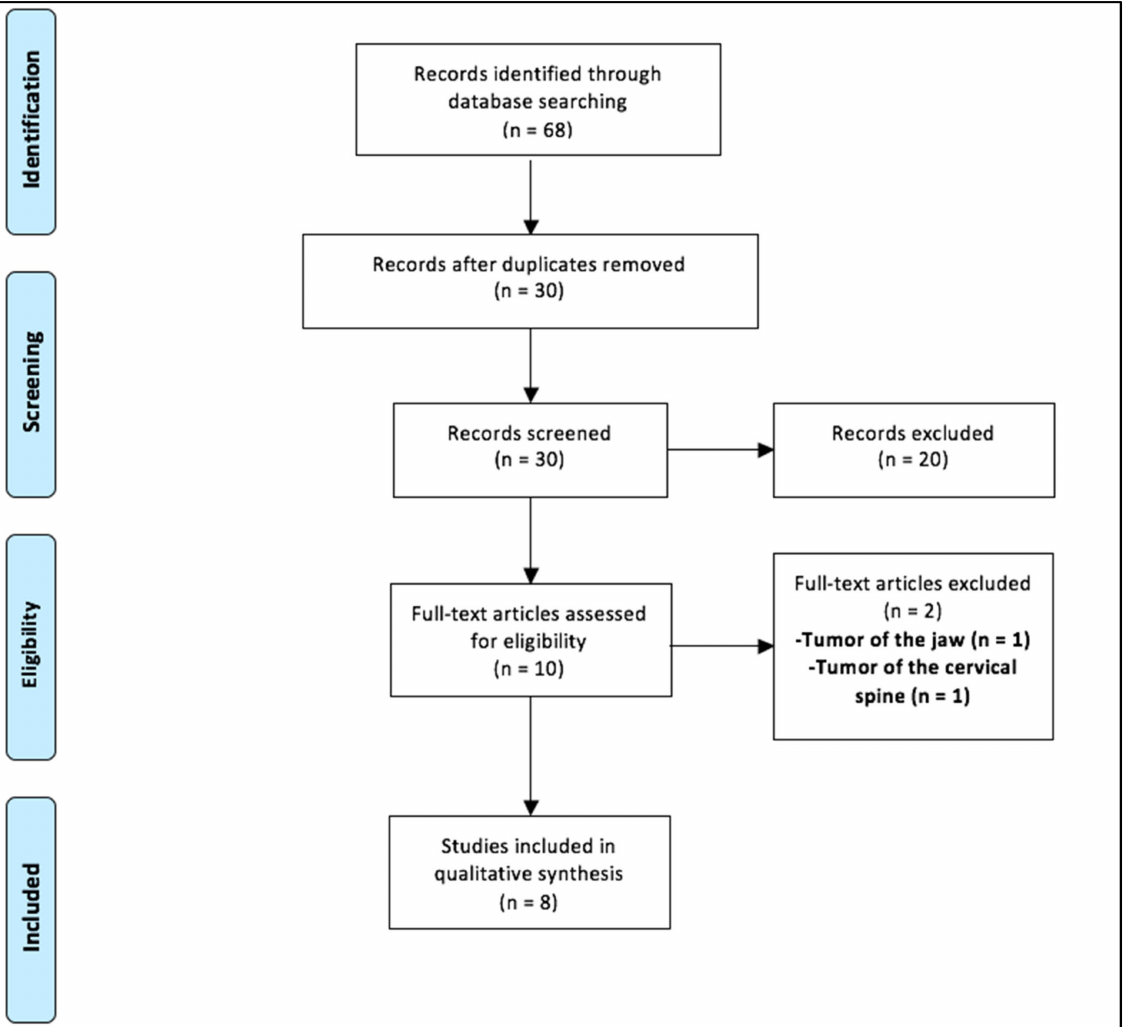
Figure 1. Selection of the relevant studies using the Preferred Reporting Items for Systematic Review and Meta-Analysis (PRISMA) flow